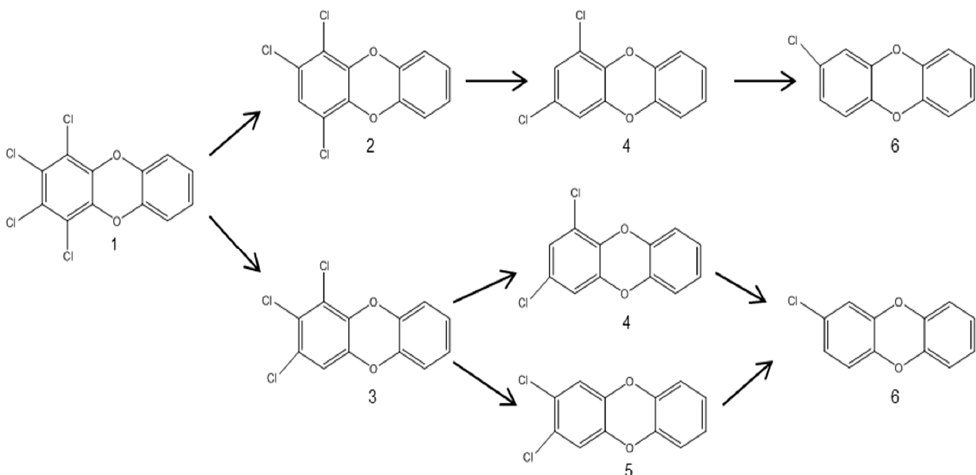
Figure 7. Proposed pathway for the dechlorination of 1,2,3,4-TeCDD ( 1 ) and 1,2,3-TCDD ( 3 ) by the anaerobic consortium of river sediment from the Saale River [79,81,82]. Compound definition: 1,2,3,4-tetrachlorodibenzo- p -dioxin (1,2,3,4-TeCDD) ( 1 ); 1,2,4-trichlorodibenzo- p -dioxin (1,2,3-TCDD) ( 2 ); 1,2,3-trichlorodibenzo- p -dioxin (1,2,3-TCDD) ( 3 ); 1,3-dichlorodibenzo- p -dioxin (1,3-DCDD) ( 4 ); 2,3-dichlorodibenzo- p -dioxin (2,3-DCDD) ( 5 ); 2-monochlorodibenzo- p -dioxin ( 6 ).